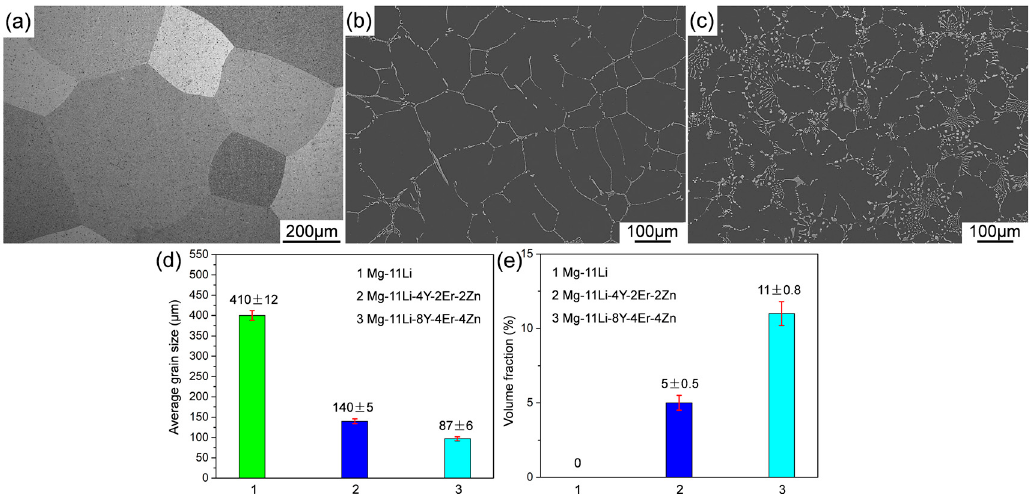
Figure 1. Microstructure of the as-cast alloys: ( a ) optical microscope (OM) image of Mg-11Li, scanning electron microscope (SEM) images of ( b ) Mg-11Li-4Y-2Er-2Zn and ( c ) Mg-11Li-8Y-4Er-4Zn, ( d ) average grain size, and ( e ) average volume fraction of secondary phases.